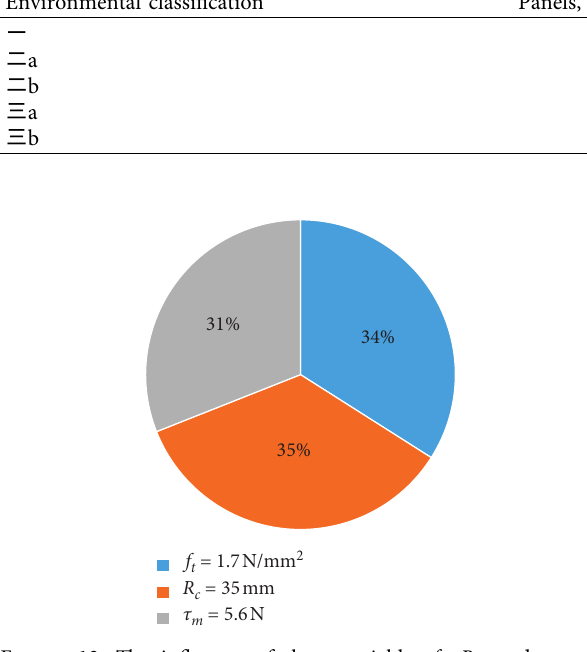
Beams, columns, and poles